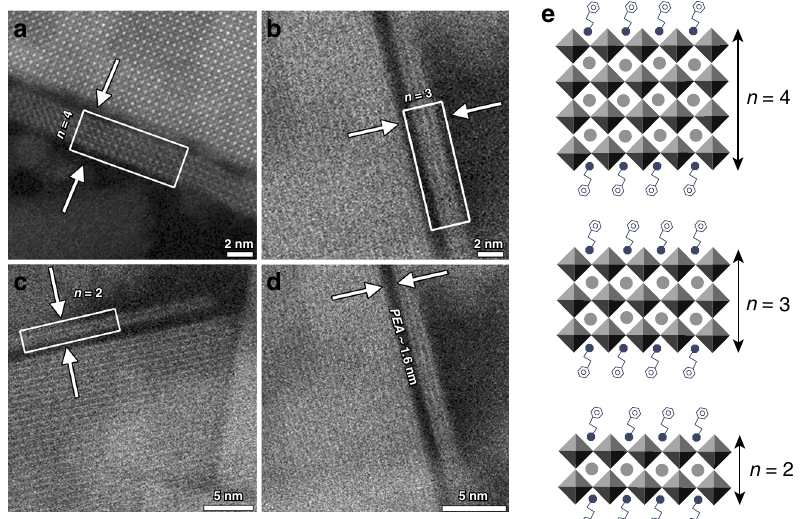
Fig. 1 Visualization of reduced-dimensional perovskites. High-angle annular dark fi eld (HAADF) scanning transmission electron microscopy (STEM) images of the layered perovskites exhibiting domains with different number of layers ( a – d ), where in a , a four-layered structure was